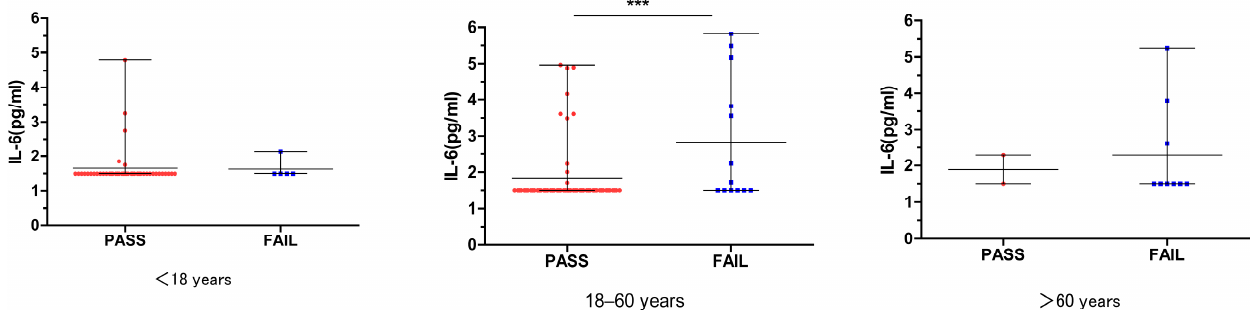
Figure 3. Relationship between DPOAE and IL-6 in different age groups. *** p = 0.005.